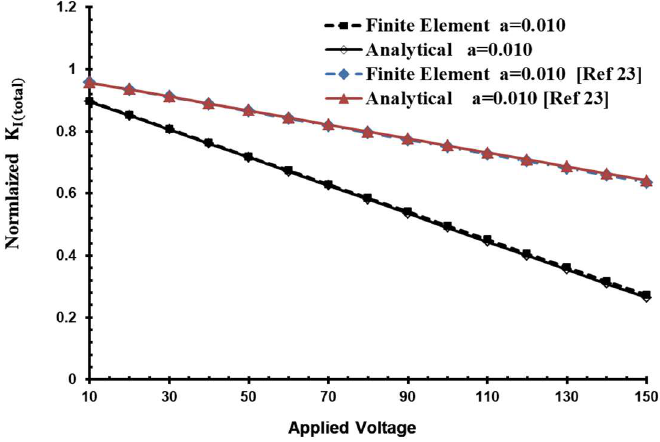
Figure 10. Variation of NSIF with applied voltage for double-sided and single-sided configurations.